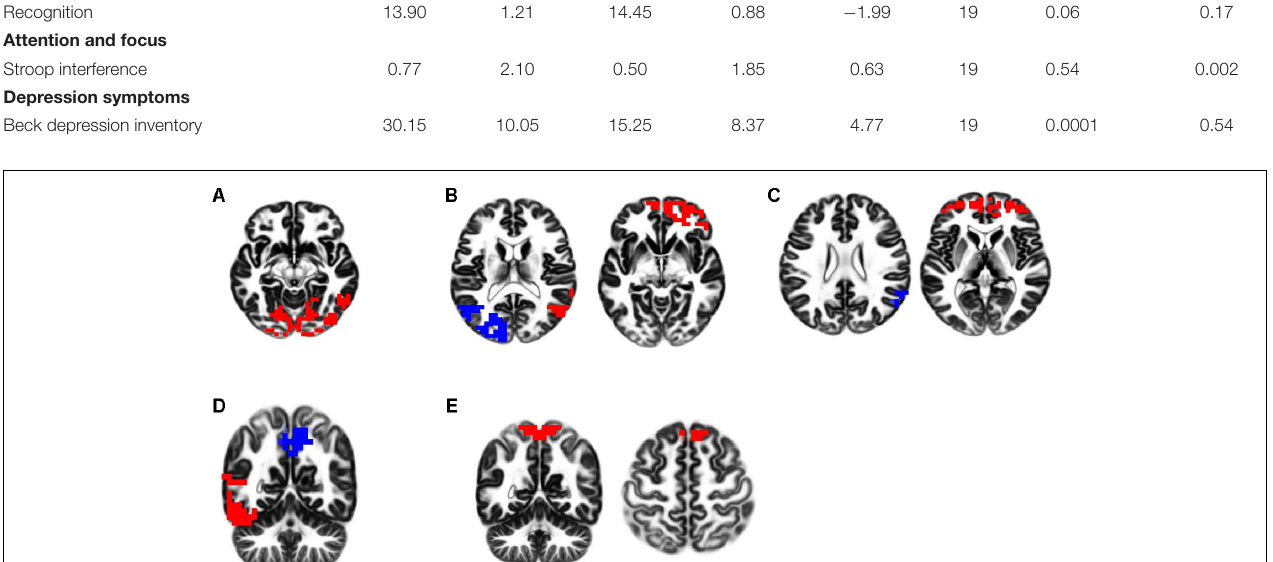
(VVP) in alpha and beta frequency bands and left posterior dorsal visual pathway (DVP) in alpha frequency band; (3) IC-6: self-referential processing network (DMN),